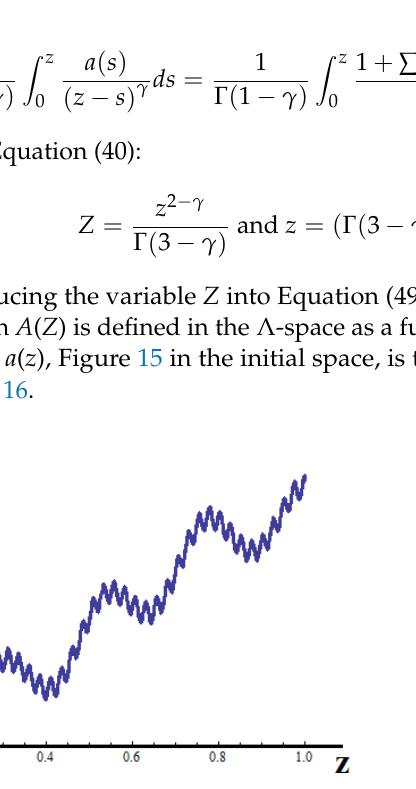
Figure 15. The (dimensionless) distribution of the cross-sectional area α ( z ).